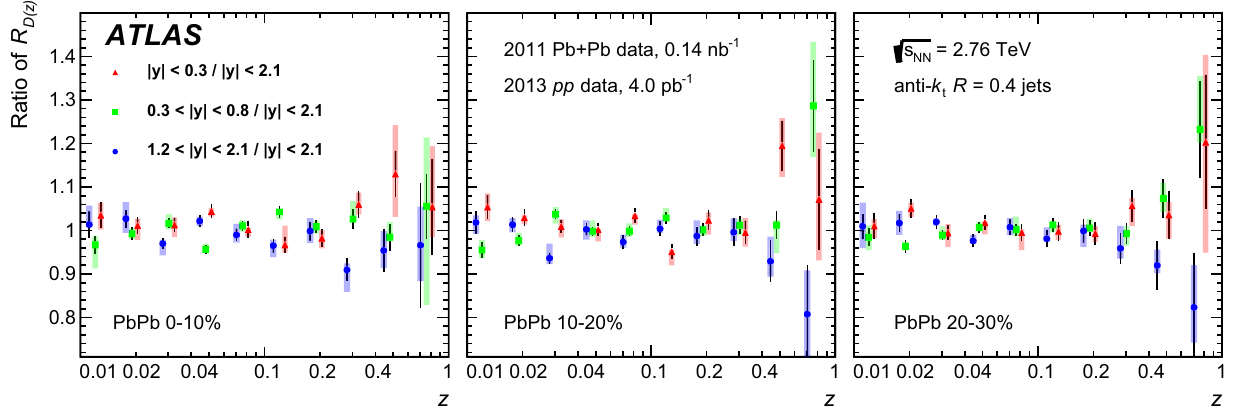
Fig. 9 The ratio of R D ( z ) distributions in a given rapidity interval, namely | y | < 0 . 3, 0 . 3 < | y | < 0 . 8, and 1 . 2 < | y | < 2 . 1, to R D ( z ) in | y | < 2 . 1. The ratio of R D ( z ) was evaluated for three different col-